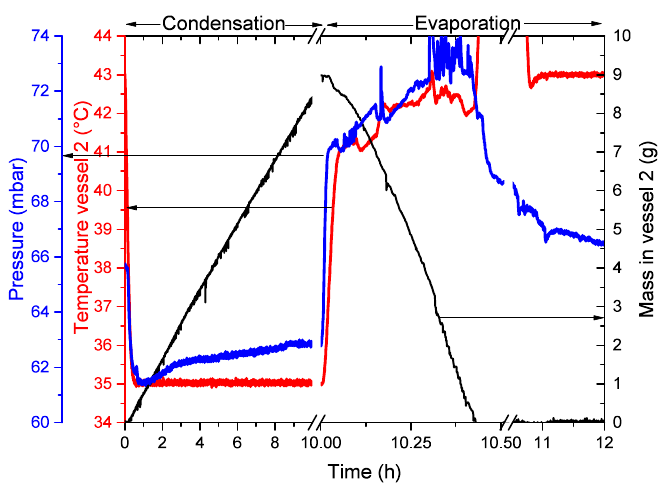
Figure 10. The pressure (blue), temperature (red) and mass in vessel 2 (black) during the 7th cycle.